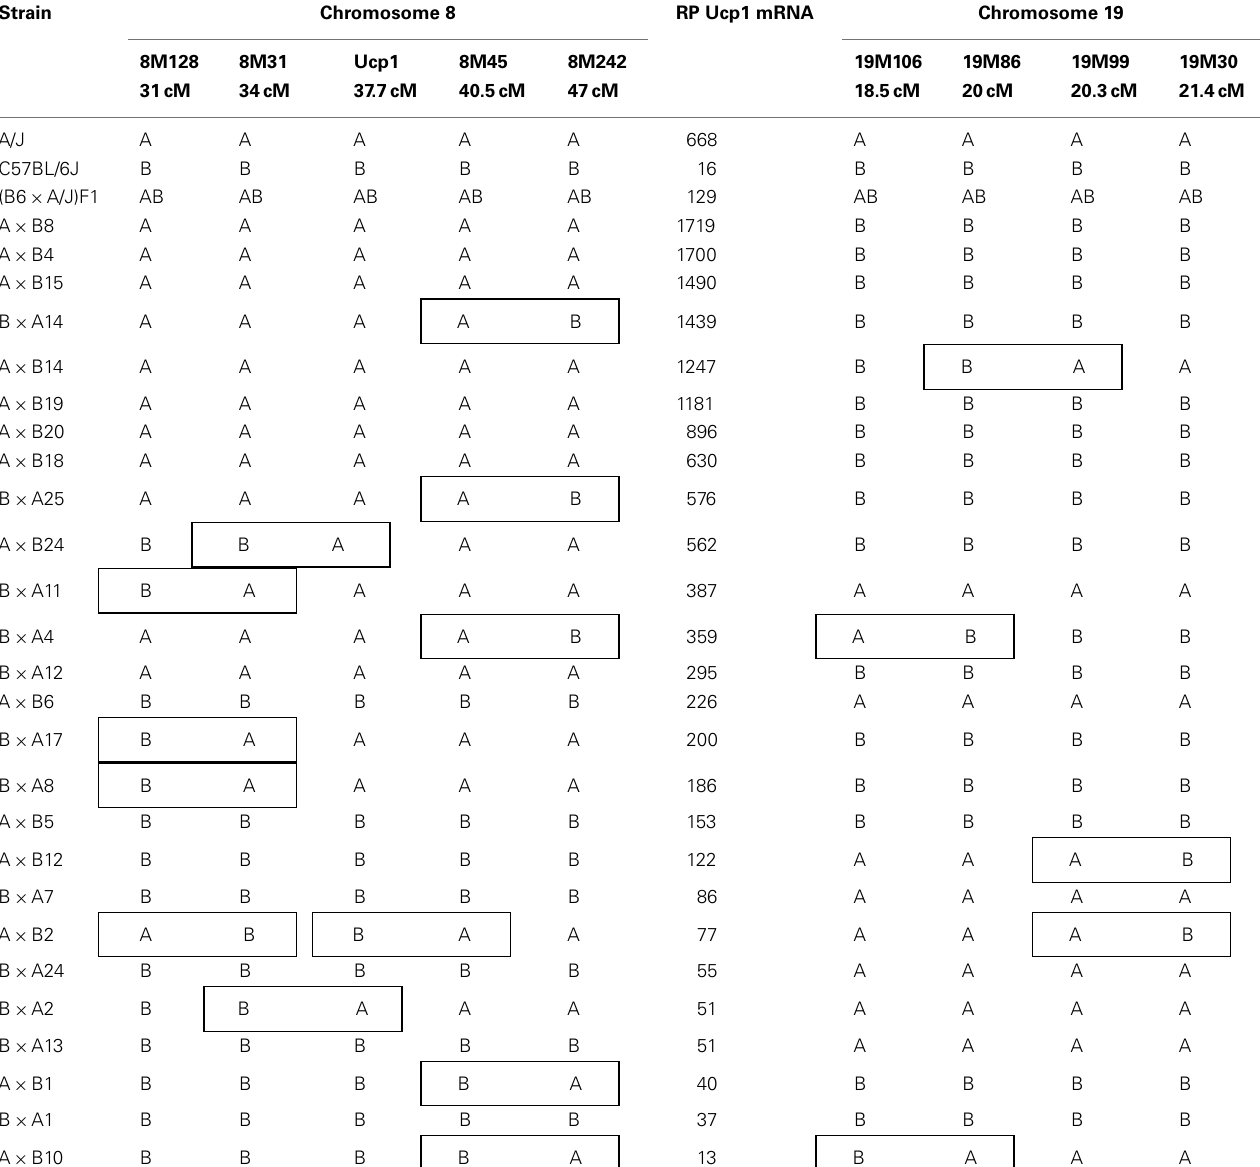
Table 2 | Strain distribution pattern in RI lines in relationship to Ucp 1 mRNA levels.